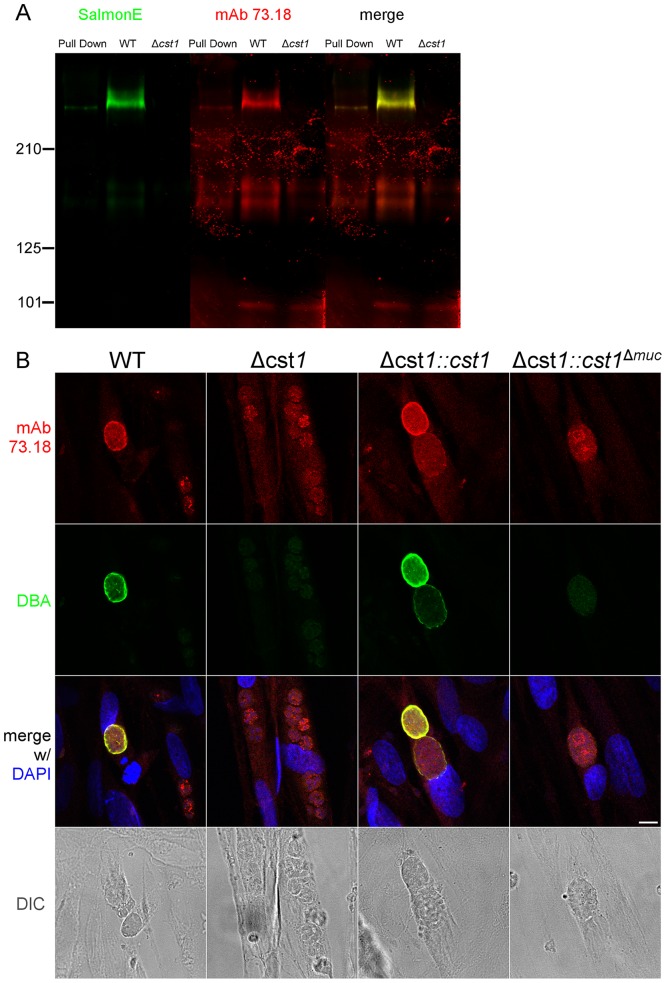
SalmonE and mAb 73.18 recognize CST1 (TGME49_064660).(A) Immunoblot of mAb SalmonE immunoprecipitated material (ME49), WT lysate (Pru) and Δcst1 lysate probed with mAb SalmonE (green) and mAb 73.18 (red). This immunoblot demonstrated that mAb SalmonE and mAb 73.18 bind to the same major species which is not detectable in Δcst1 parasites. (B) IFA of in vitro cysts probed with CST1 specific monoclonal antibody 73.18 (red) and DBA lectin (green). The presence of full-length CST1 is required for both mAb 73.18 and DBA cyst wall staining. Bar, 10 µm.